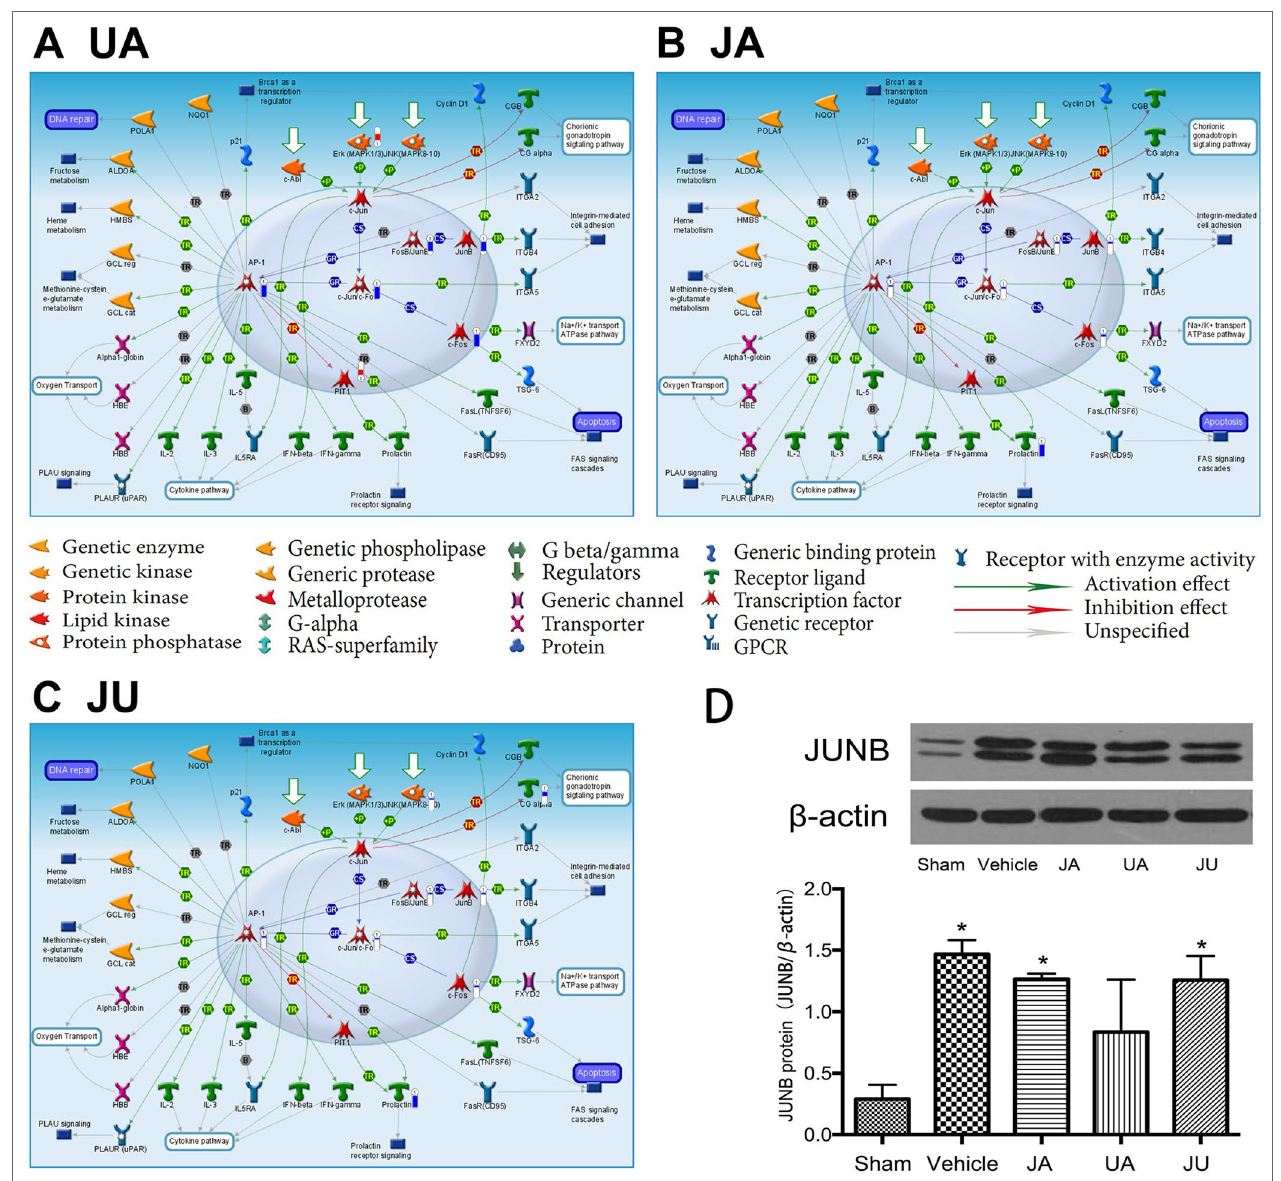
FIGURe 3 | Differentially expressed genes in eTranscription_Role of activator protein 1 in regulation of cellular metabolism” of different treatment groups. (A) Ursodeoxycholic acid group. (B) Jasminoidin group. (C) JA and UA combination group. (D) Biological verification of JunB proto-oncogene by Western blot, *P < 0.05 vs. sham.